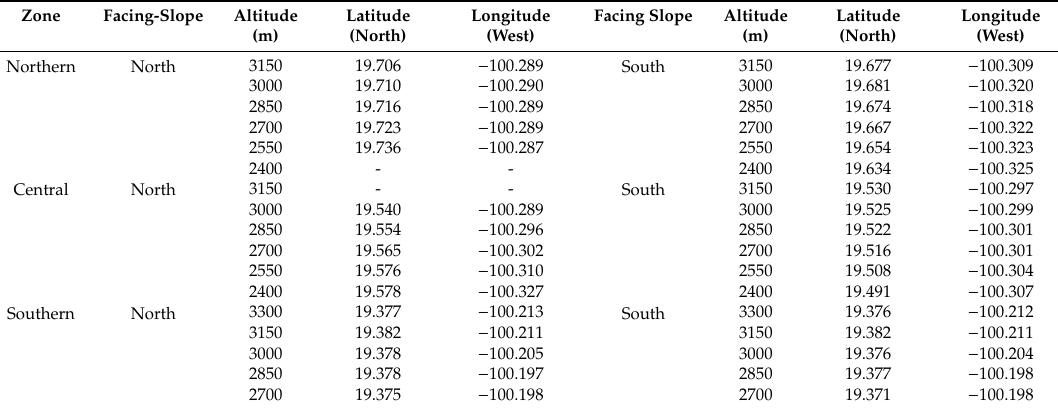
Table 1. Location of sampling sites in the Monarch Butterfly Biosphere Reserve (MBBR), according to zone, facing-slope, and